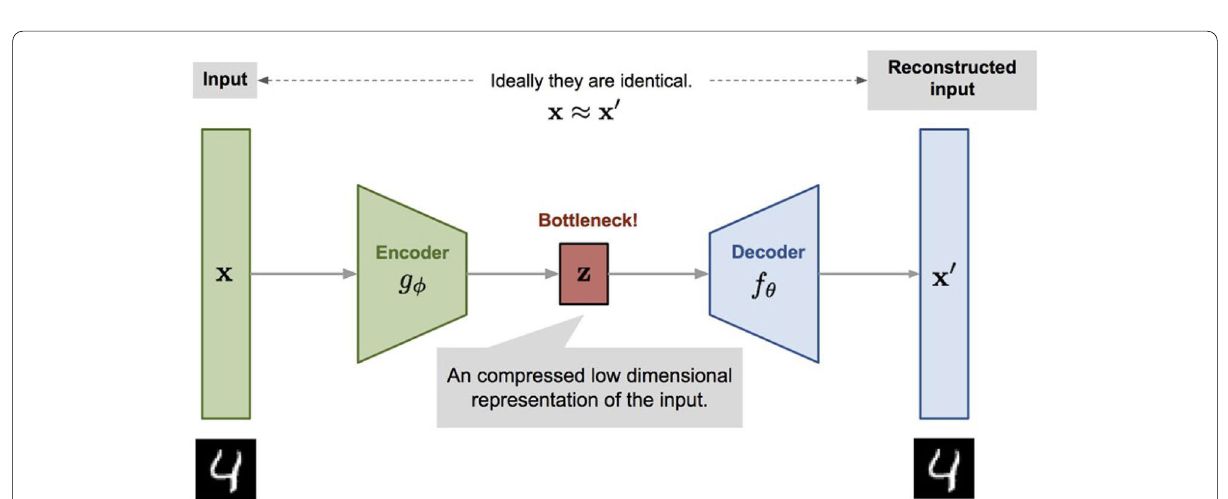
Fig. 5 Illustration of a traditional encoder-decoder or autoencoder model (Weng,